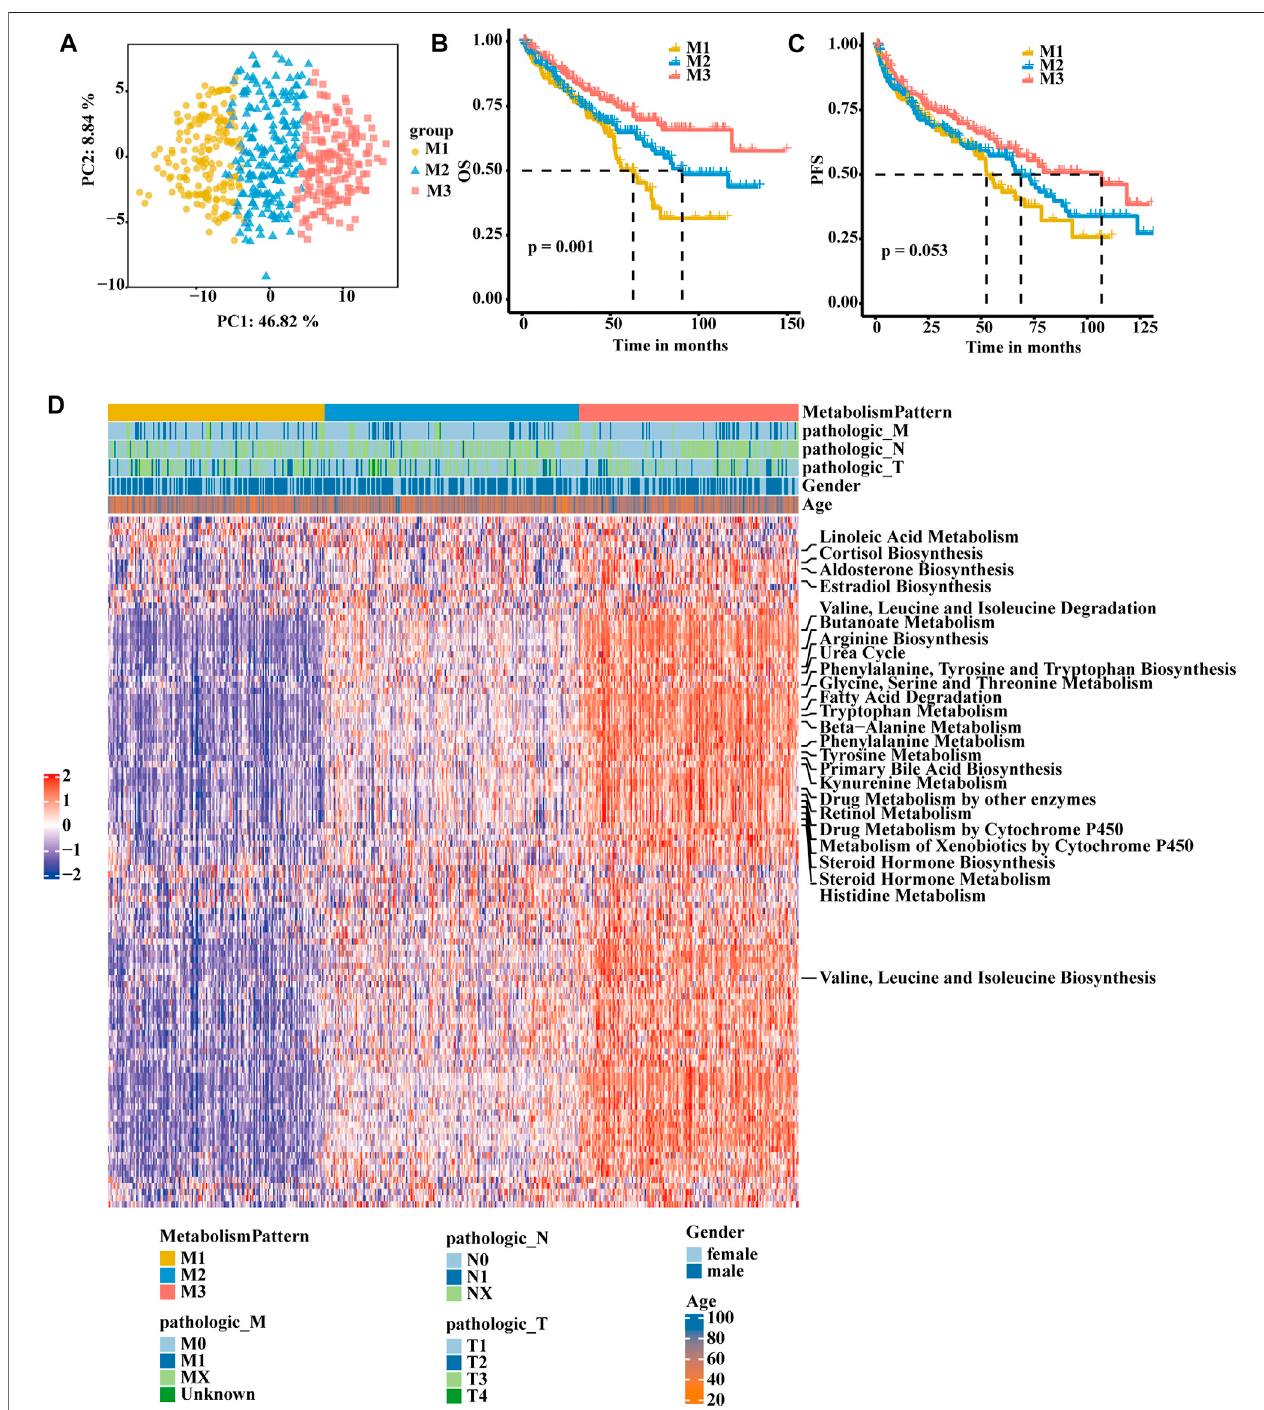
FIGURE 1 | Identi fi cation of RCC subclasses according to metabolism-associated signatures in the TCGA-KIRC cohort. (A) Principal component analysis of the pathway activity of three metabolism-related patterns, showing a remarkable difference in pathway activity between the different metabolism patterns. (B) OS analyses forthethreemetabolism-relatedpatternsbasedonpatientswithKIRCfromTCGAcohorts. (C) PFSsurvivalanalysesforthethreemetabolism-relatedpatternsbasedon patientswithKIRCfromTCGAcohorts. (D) Consensusclusteringof113metabolism-relatedgenesignaturesbetweenthethreemetabolism-relatedclustersinthe TCGA-KIRC